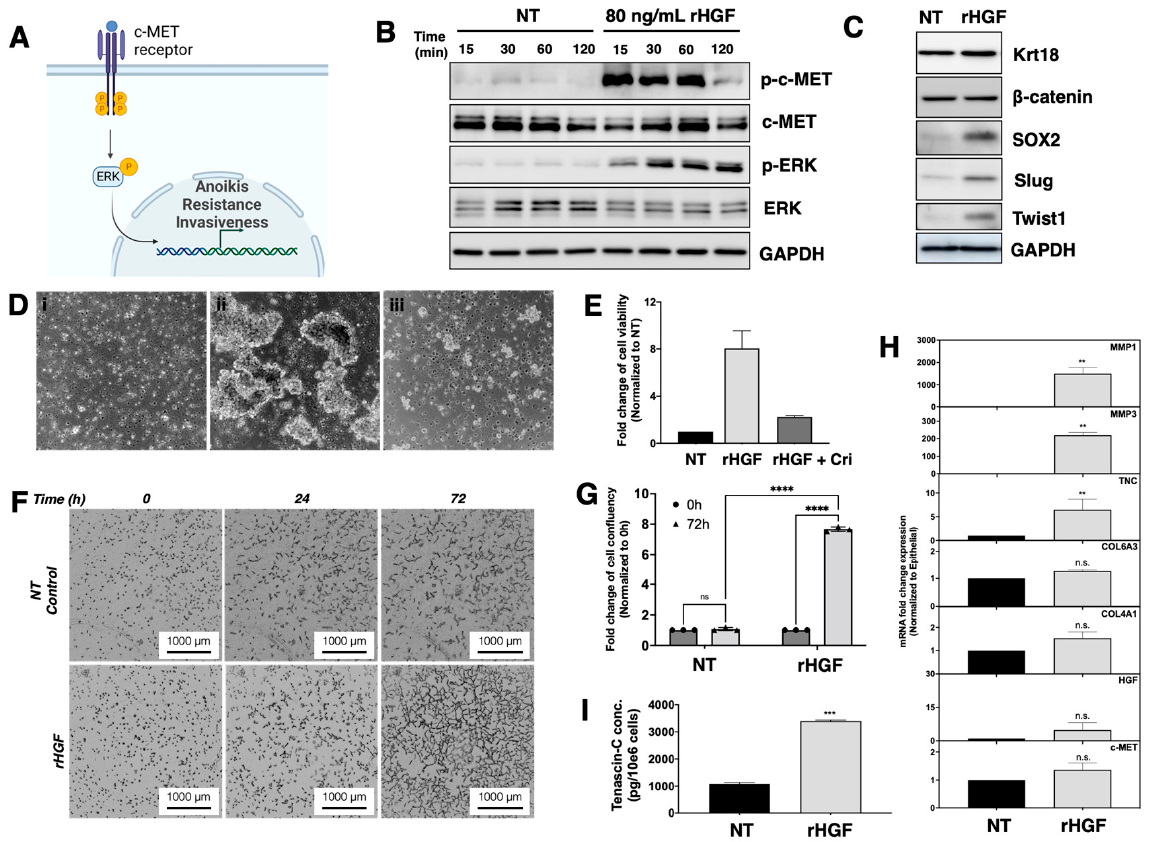
Figure 7. The effect of HGF treatment in the epithelial ovarian cancer cells. ( A ) Proposed scheme of the HGF pathway in ovarian cancer cells. ( B ) Characterization of the classical HGF pathway was achieved by the Western blot of R182 treated with 80 ng/mL rHGF for 15–120 min compared to their respective NT control for their expression of phosphorylated c-MET (p-c-MET), total c-MET, phosphorylated ERK, and total ERK. ( C ) Characterization of EMT markers following 80 ng/mL rHGF treatment in R182. ( D ) Anoikis assay for R182: (i) NT control, (ii) 80 ng/mL rHGF, and (iii) 80 ng/mL rHGF and 100 nM Crizotinib. ( E ) Quantification of cell viability for the anoikis assay presented as fold change normalized to NT control. ( F ) Invasion assay of R182 in the presence or absence of 80 ng/mL rHGF for 0, 24, and 72 h. ( G ) Quantification of the invasion assay presented as a fold change of cell confluency normalized to cells in 0 h (time of seeding). Bars represent means ± SEM; p -value **** < 0.0001, n.s. = non-significant. Two-way ANOVA was used to define the p -value. ( H ) Bar plot of qPCR for MMP1, MMP3, TNC, COL6A3, COL4A1, HGF, and c-MET mRNA expression. GAPDH expression was used as the house-keeping gene. Bars represent the means ± SEM; p -value ** < 0.01, n.s. = non-significant. Student t -test was used to define p -value. ( I ) Quantification of secreted TNC concentration following 80 ng/mL rHGF treatment for 48 h. Bars represent the means ± SEM; p -value *** < 0.001. Student t -test was used to define the p